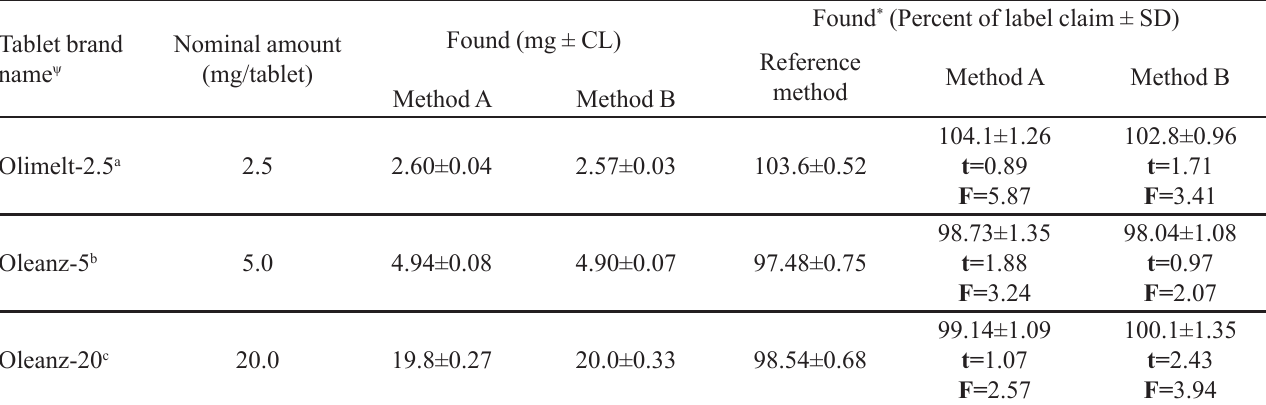
TABLE V - Results of analysis of tablets by the proposed methods and statistical comparison of the results with the reference